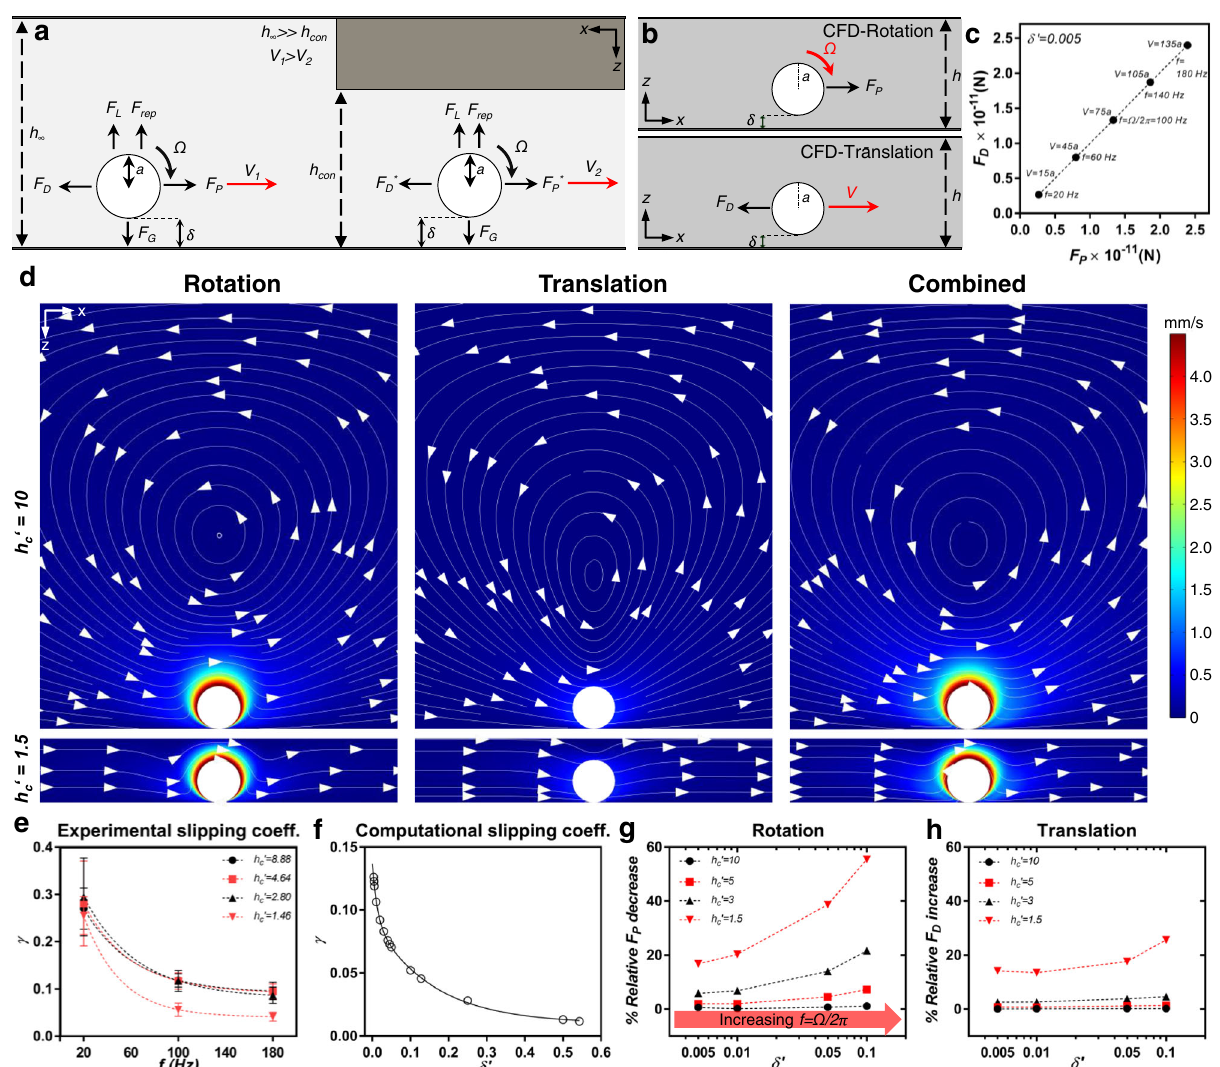
Fig. 4 | Three-dimensional (3D) computational fl uid dynamics (CFD) simula- tions of the microrollers in vertically con fi ned spaces. a Mechanistic explana- tionofthemicrorollerpropulsionwithoutandwithverticalcon fi nement.Without con fi nement, the propulsion force ( F P ) is balanced out by the drag force ( F D ) on the x -axis,andgravitationalforces( F G )arebalancedoutbyrepulsion( F rep )andlift forces( F L )onthe y -axis. δ showsthelubricationdistance.Underthecon fi nement, the correction factors of Eqs. 1 and 2 change and result in new forces, F P * and F D * , thus changing the overall microroller translational velocity( V ). b Summaryof the CFD simulations. The spherical objects with fi xed positions were rotated and translatedseparatelyforvalidation. c Validationofthesimulationsforanextreme lubrication distance condition, δ ’ = δ /a = 0.005 . The spheres were rotated and then translated with their calculated theoretical speed. The forces acting on the spheres were same but opposite directions (less than 0.5% difference), as they should be in the Stokes regime, demonstrating the validity of the simulations. d Flow- fi elds around the rotating, translating (theoretical speed, corresponding to the rotation frequency) and the combination of two (rotation + translation) at 180Hz, for different con fi nements h c ′ =10 and h c ′ =1.5. Colors shows the